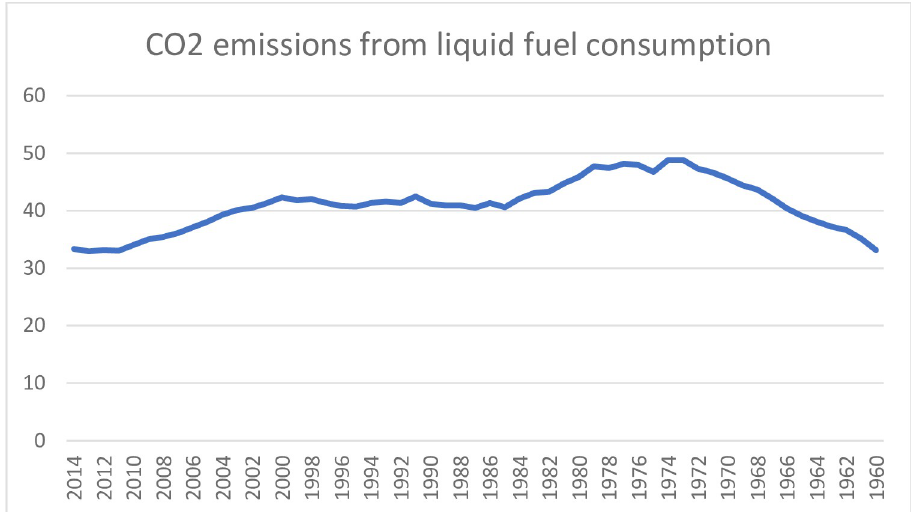
Fig 2. CO2 emission from liquid fuel consumption. Source: Authors’